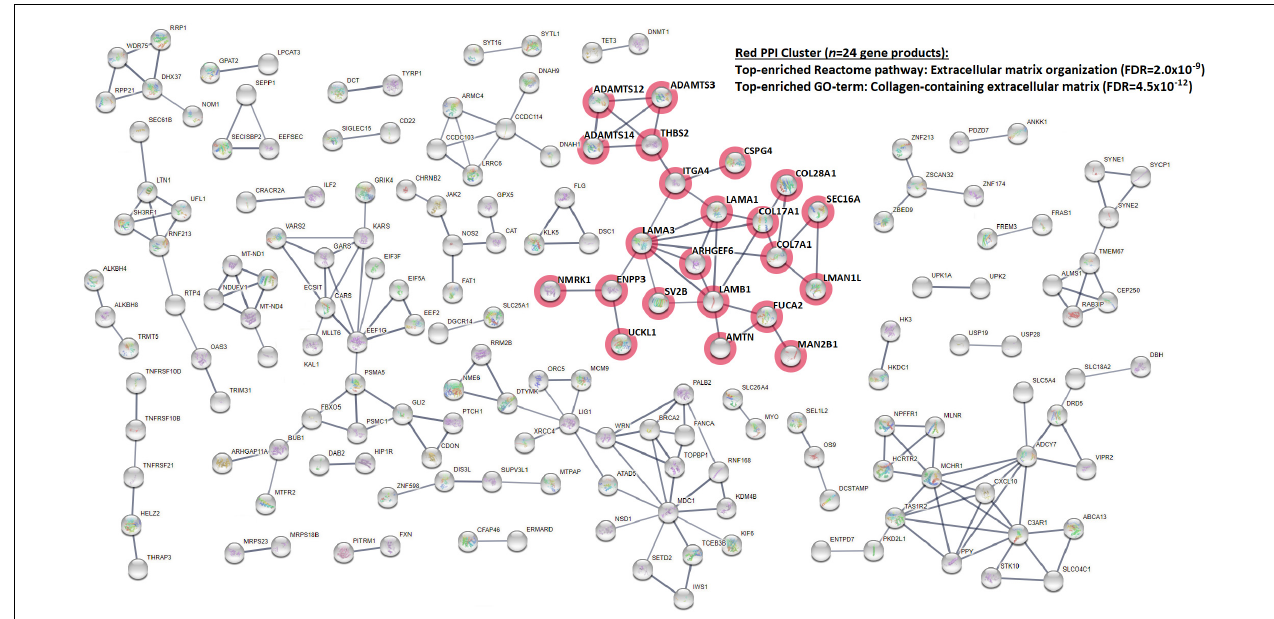
FIGURE 2 | PPI network for protein-altering SNPs with association p -values less than 0.01 for epileptic seizure. The overall network includes 34 clusters, ranging in size from 2 to 22 nodes. The largest cluster is highlighted in red, with the top-enriched reactome pathway and GO-term listed. The analyses were conducted for 441 genes with human homolog counterparts with the online program STRING v. 11.0.